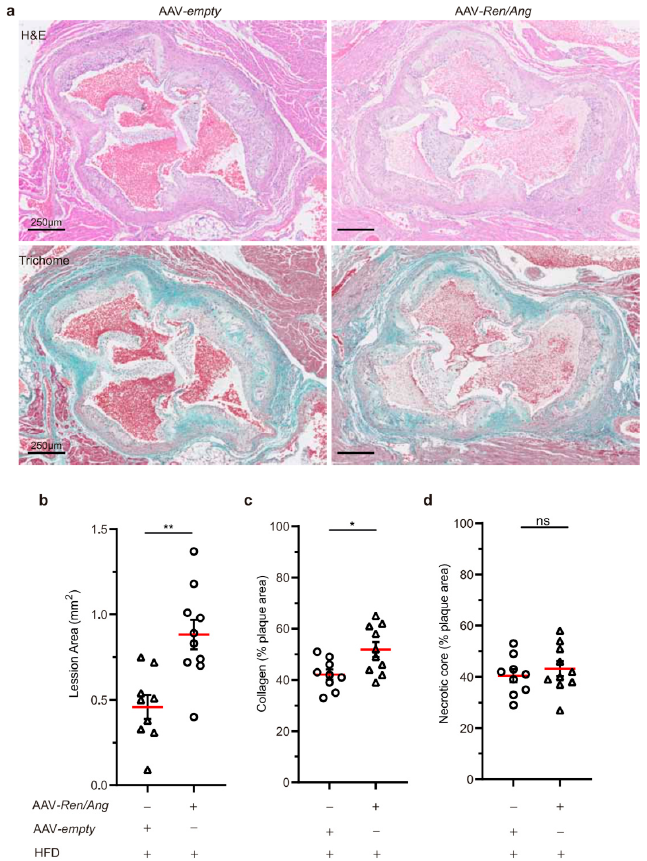
Figure 3. Non-optimal BP increases atherosclerosis at the aortic root. ( a ) Representative whole view of aortic roots from AAV-empty control and AAV- Ren/Ang -injected ApoE -/- mice stained with H&E and Masson’s trichrome. Aortas were extracted 10 weeks after starting the HFD. Scale bar, 250 μ m. ( b ) Quantification of atherosclerotic plaque area from a (n = 9–10 AAV-empty and AAV- Ren/Ang mice) indicated as mm 2 . ( c , d ) Quantification of collagen and necrotic core area expressed as a percentage of the total plaque cross-sectional area (n = 9-10). Data in ( b – d ) are mean ± SEM. * p < 0.05, ** p < 0.01, ns, non-significant, Student t -test.